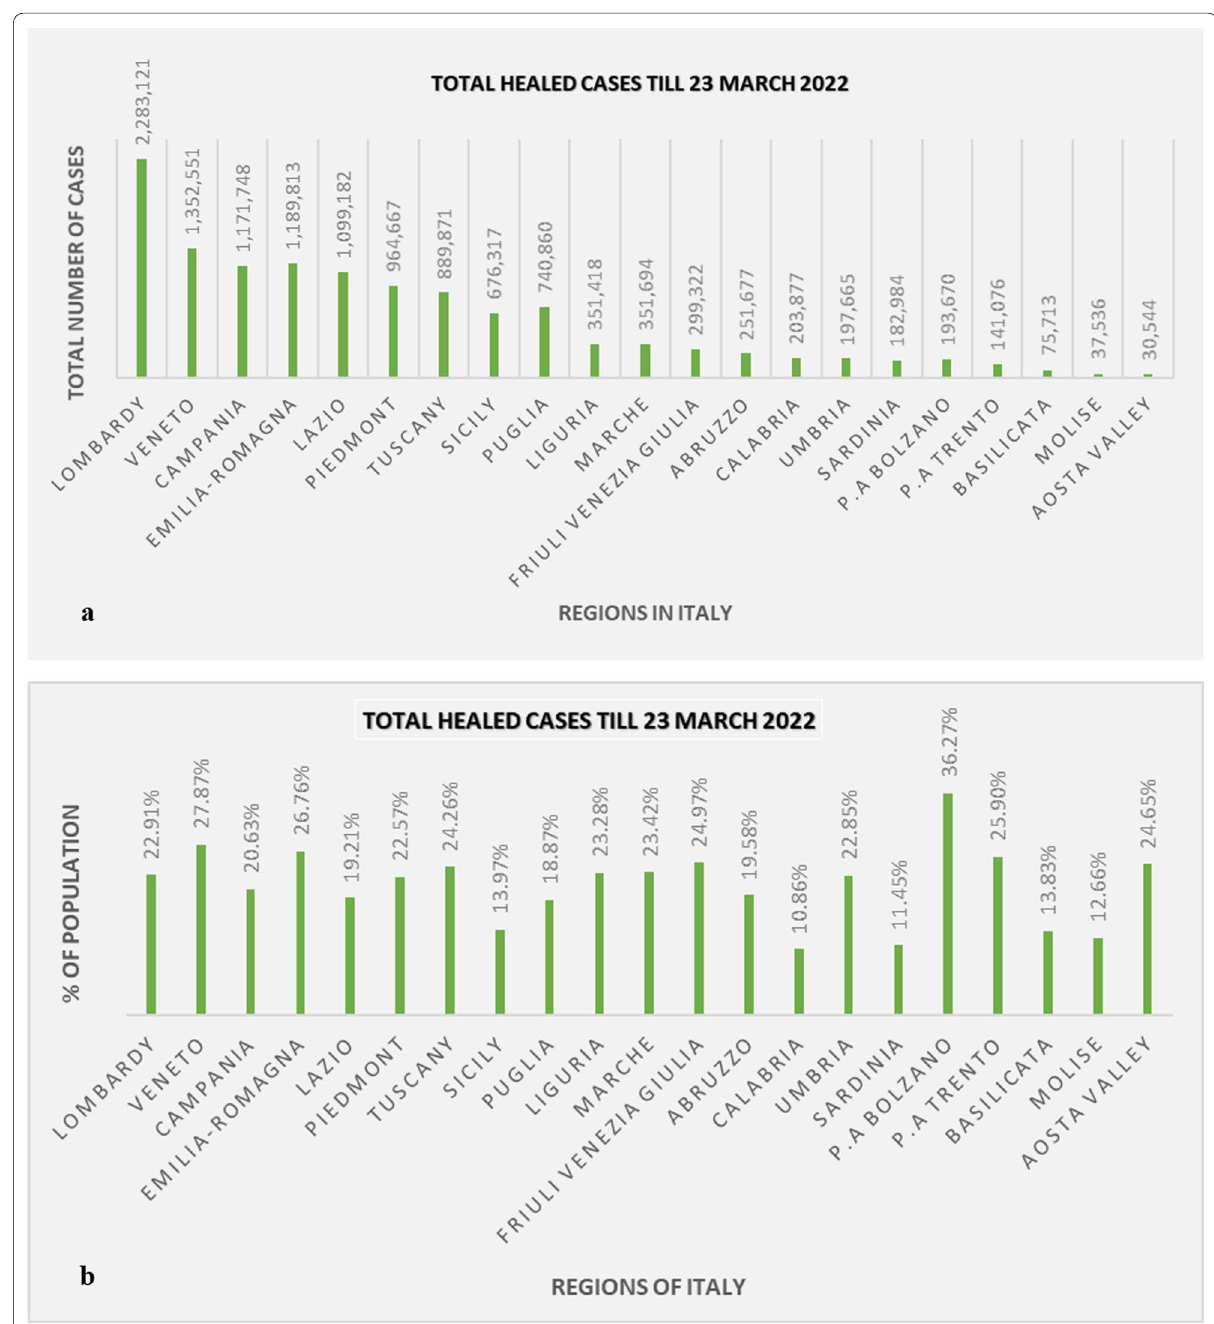
Fig. 5 These data address the estimation of total healed cases in all regions throughout the 2 years of period. a Number of recovery cases till 23 March 2022; b Total recovered cases in accordance with total population of each region of Italy. Details are given in the